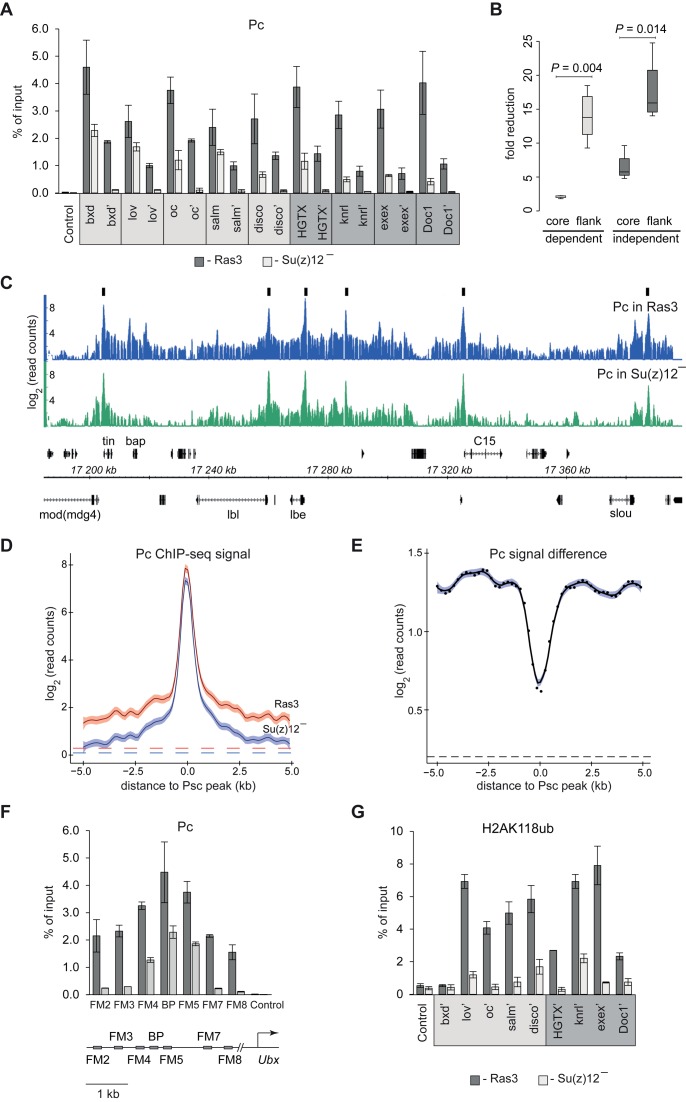
Loss of H3K27me3 makes interaction of Pc with chromatin around PREs less stable. (A) ChIP-qPCR analysis shows that in Su(z)12 minus cells the immunoprecipitation of chromatin with antibodies against Pc is preferentially lost at amplicons flanking PREs (marked with apostrophes) compared to amplicons corresponding to PRE cores. Here and in (G), PRC2:PRC1 dependent PREs are marked with light grey box and PRC2:PRC1 independent PREs are marked with dark grey box. (B) The fold reduction of Pc ChIP signals at core and flanking amplicons at PRC2:PRC1 dependent (light grey) and PRC2:PRC1 independent (dark grey) PREs is summarized in box-plots. The boxplots indicate the median and span the inter-quartile range. The whiskers indicate the lowest and the highest values. The differences between PRE cores and flanks are statistically significant (Wilcoxon rank sum test). (C) ChIP-seq profiles of Pc binding within the cluster of NK-homeobox genes in Ras3 and Su(z)12 minus cells. Note that in the mutant cells the signal at Pc ‘tails’ is reduced more than at peak summits. The positions and the exon structure of annotated transcripts are shown above (transcribed left to right) and below (transcribed right to left) the coordinate scale (in kb). Black boxes illustrate positions of Psc peaks used in the analyses below. (D) Cumulative distributions of Pc ChIP-seq signals around 122 isolated (>10 kb to the nearest neighbor) Psc peaks. The shades around fitted curves indicate 95% confidence interval. Dashed lines indicate average ChIP-seq signals outside PcG target genes in Ras3 (red) Su(z)12 deficient cells (blue). (E) The difference between cumulative distributions of ChIP reads, but not of the reads from corresponding input materials (Figure S9B and C), illustrates that the ChIP-seq signal at a distance from the Psc peaks is reduced more than at peak summits. Black dots indicate the differences between corresponding points on fitted curves in D and the blue shade indicates the 95% confidence interval for fitting the smooth curve. The difference between average signals outside PcG target genes (black dashed line) is shown for comparison. (F) Detailed analysis of Pc ChIP around bxd-PRE in control Ras3 and Su(z)12 minus cells. The relative position of amplicons is shown below the histogram. ‘BP’ amplicon marks the bxd-PRE core (30). (G) The results of ChIP-qPCR with antibodies against H2AK118ub.